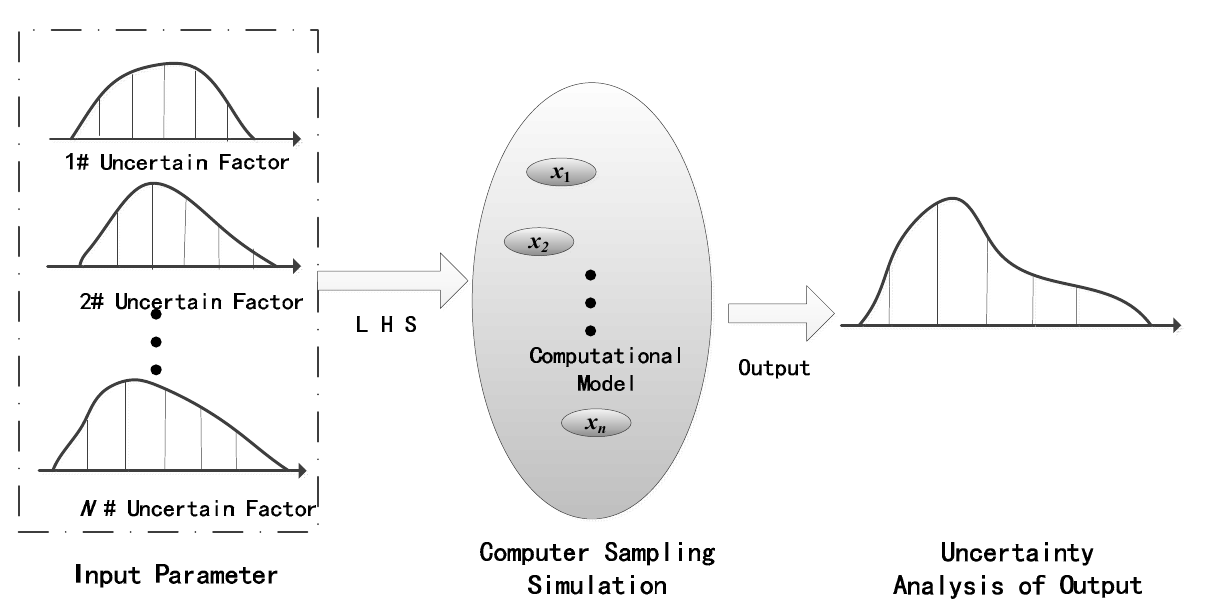
Figure 7. Flow chart of uncertainty analysis in fire temperature rise.